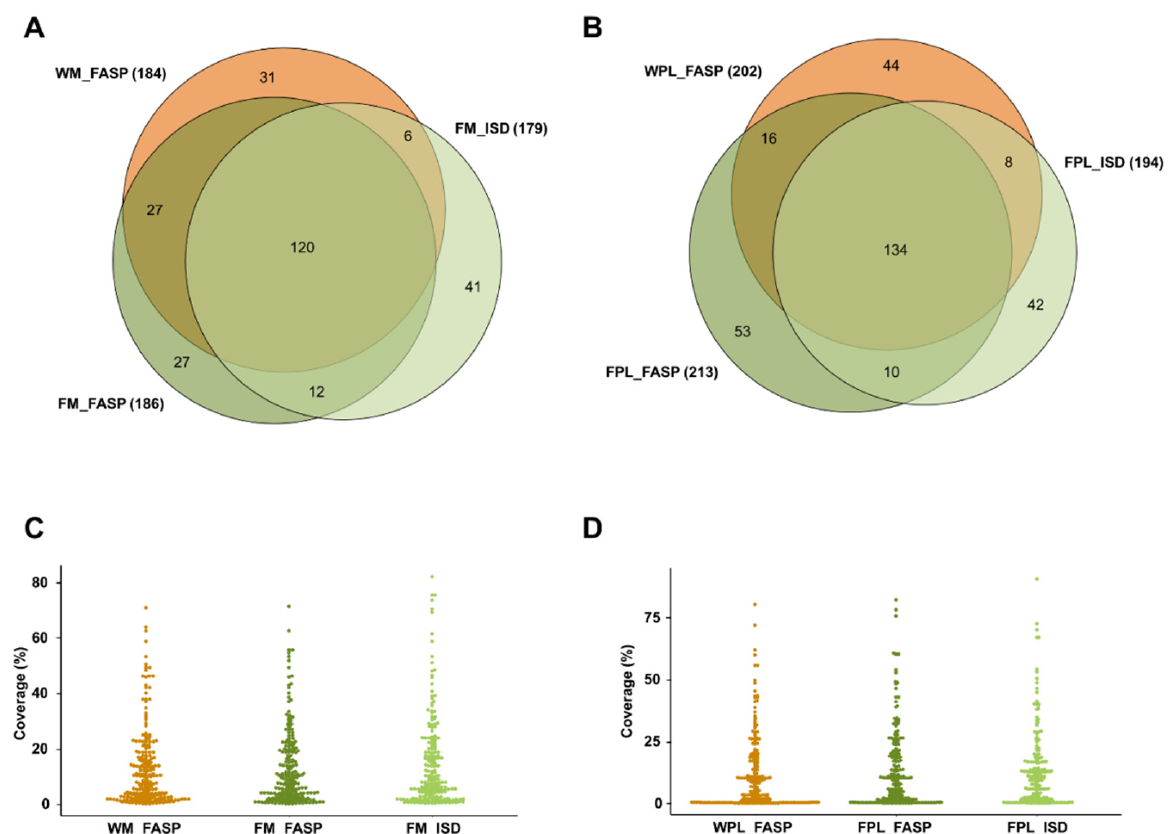
Figure 2. Quantitative Venn diagrams for proteins ( A ) identified in human milk (M) and ( B ) plasma (PL) identified after digesting a diluted aliquot of the whole sample (W) by FASP as well as protein extracts (F) by FASP and in-solution digestion (ISD). Percentage protein coverages for ( C ) human milk and ( D ) plasma grouped by the sample preparation method. Experiments were performed in three independent replicates. Identifications are presented as total numbers of unique proteins for each procedure.